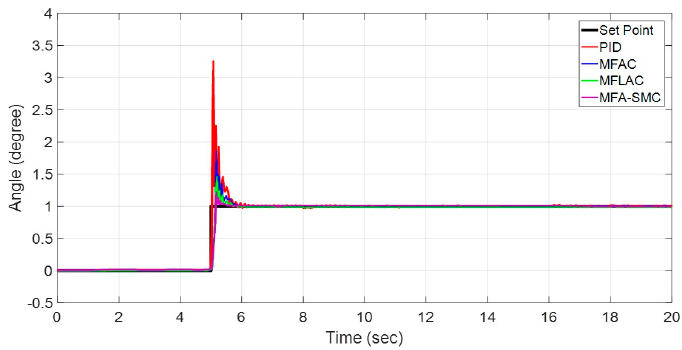
14 of 16 Figure 16. Step response of BLDC Motor using Model Free Adaptive and Sliding Mode Control. 4. Simulation Results and Analysis This section discusses the performance analysis between the PID, MFAC, MFLAC, and MFA- SMC schemes. Figure 17 shows the step response of the BLDC motor. Table 2 summarizes the performance analysis of the different control algorithms. Table 2 shows that Conventional PID has a Maximum Overshoot of 3.26, a settling time of 1.251, and a rise time of 0.021. Similarly, MFAC has a Maximum Overshoot of 1.85, a settling time of 0.822, and a rise time of 0.134, and it is better than conventional